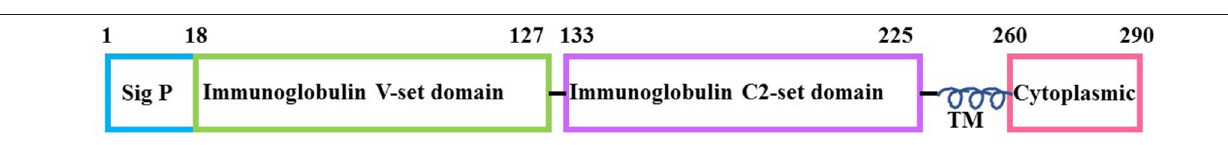
FIGURE 2 | The structure of PD-L1 protein molecule. The numbers represent the amino acid. Sig P, signal peptide; it directs PD-L1 toward cell membrane; TM, transmembrane domain; Cytoplasmic: the cytoplasmic or intracellular domain of PD-L1. The intracellular domain contains several conserved motifs: RMLDVEKC, DTSSK and